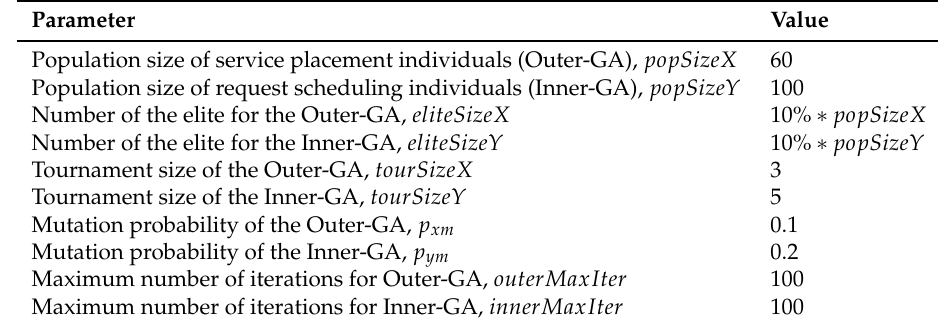
Table 1. Nested-GA